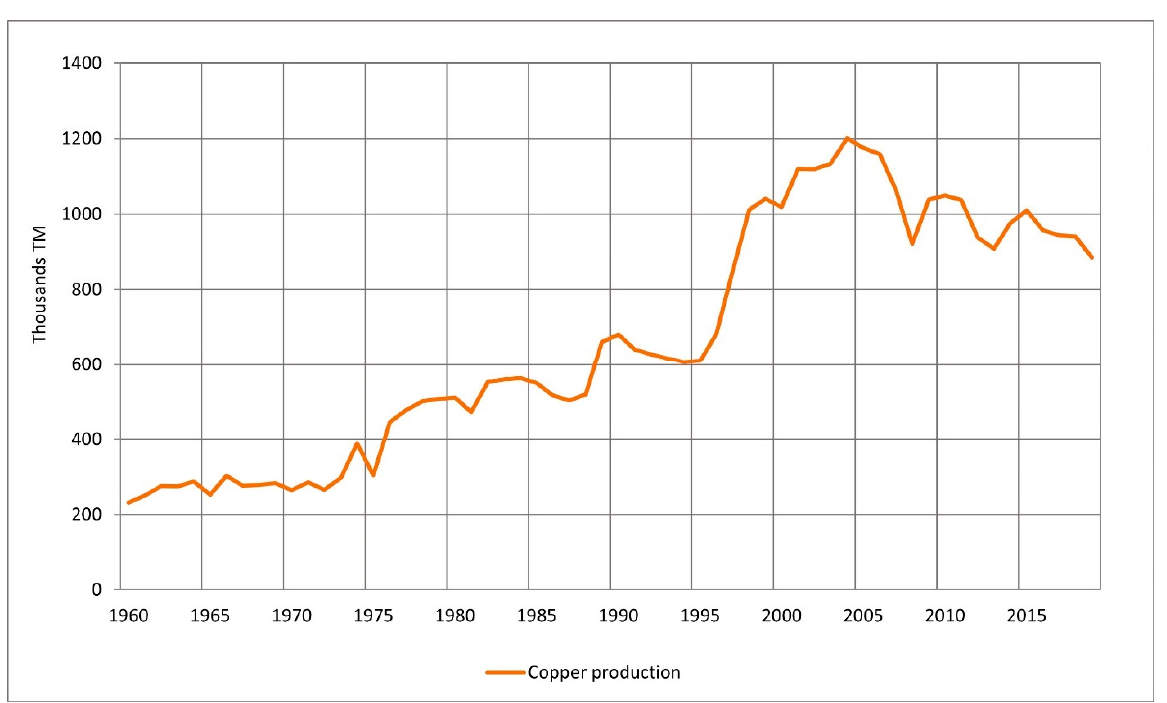
Figure 3. Production of large copper mining in the Loa River basin in thousands TM.